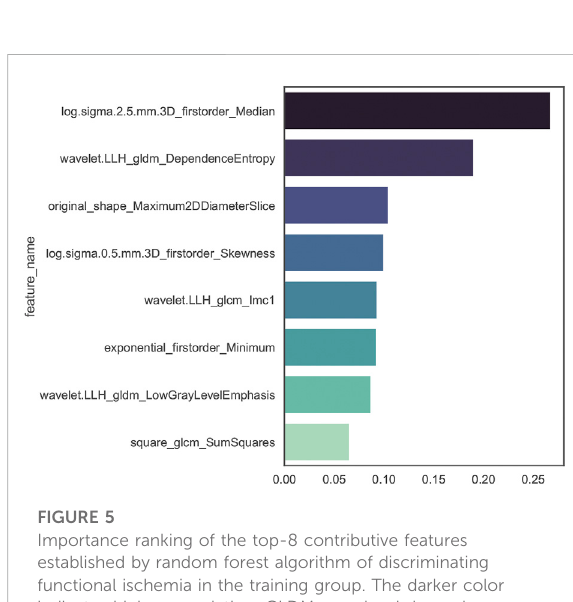
FIGURE 5 Importance ranking of the top-8 contributive features established by random forest algorithm of discriminating functional ischemia in the training group. The darker color indicates higher correlation. GLDM, gray level dependence matrix; GLCM, gray level co-occurrence